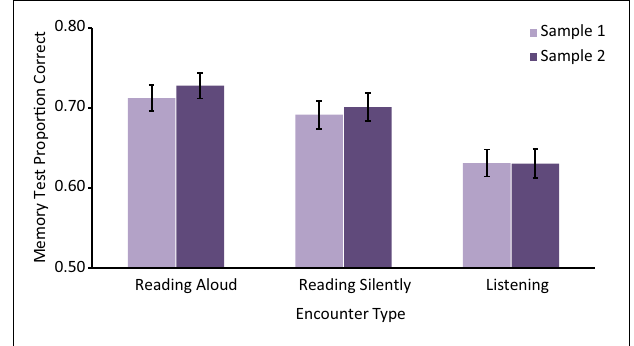
FIGURE 2 | Mean Memory Test Proportion Correct across reading encounters. Error bars represent one standard error of the mean.